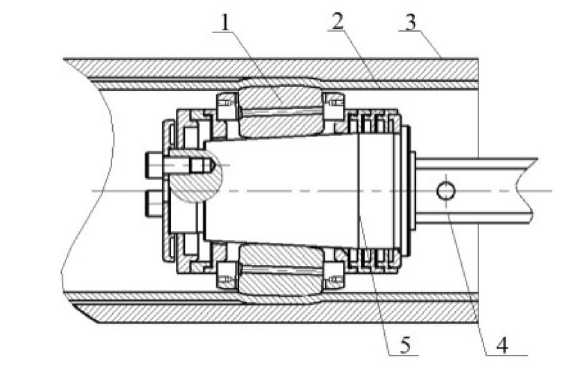
Fig. 1 The device for bimetal composite pipe formed by spinning process